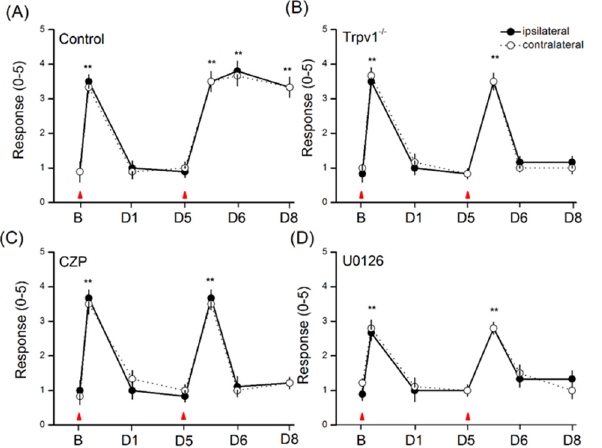
Fig 9. Targeting TRPV1 and ERK signaling pathway attenuated mechanical hyperalgesia by von Frey filaments. (A) Mechanical responses of FM mice. (B) Mechanical responses of Trpv1 -/- mice. (C) Mechanical responses of FM mice pretreated with CZP. (D) Mechanical responses of FM mice pretreated with U0126. Mice were tested before injection (baseline, B), 4 hours after injection, day 1 (D1), day 5 (D5), day 6 (D6), and day 8 (D8). Red arrowheads indicate acid injection. ** p < 0.01 compared to baseline. (n = 6 mice per